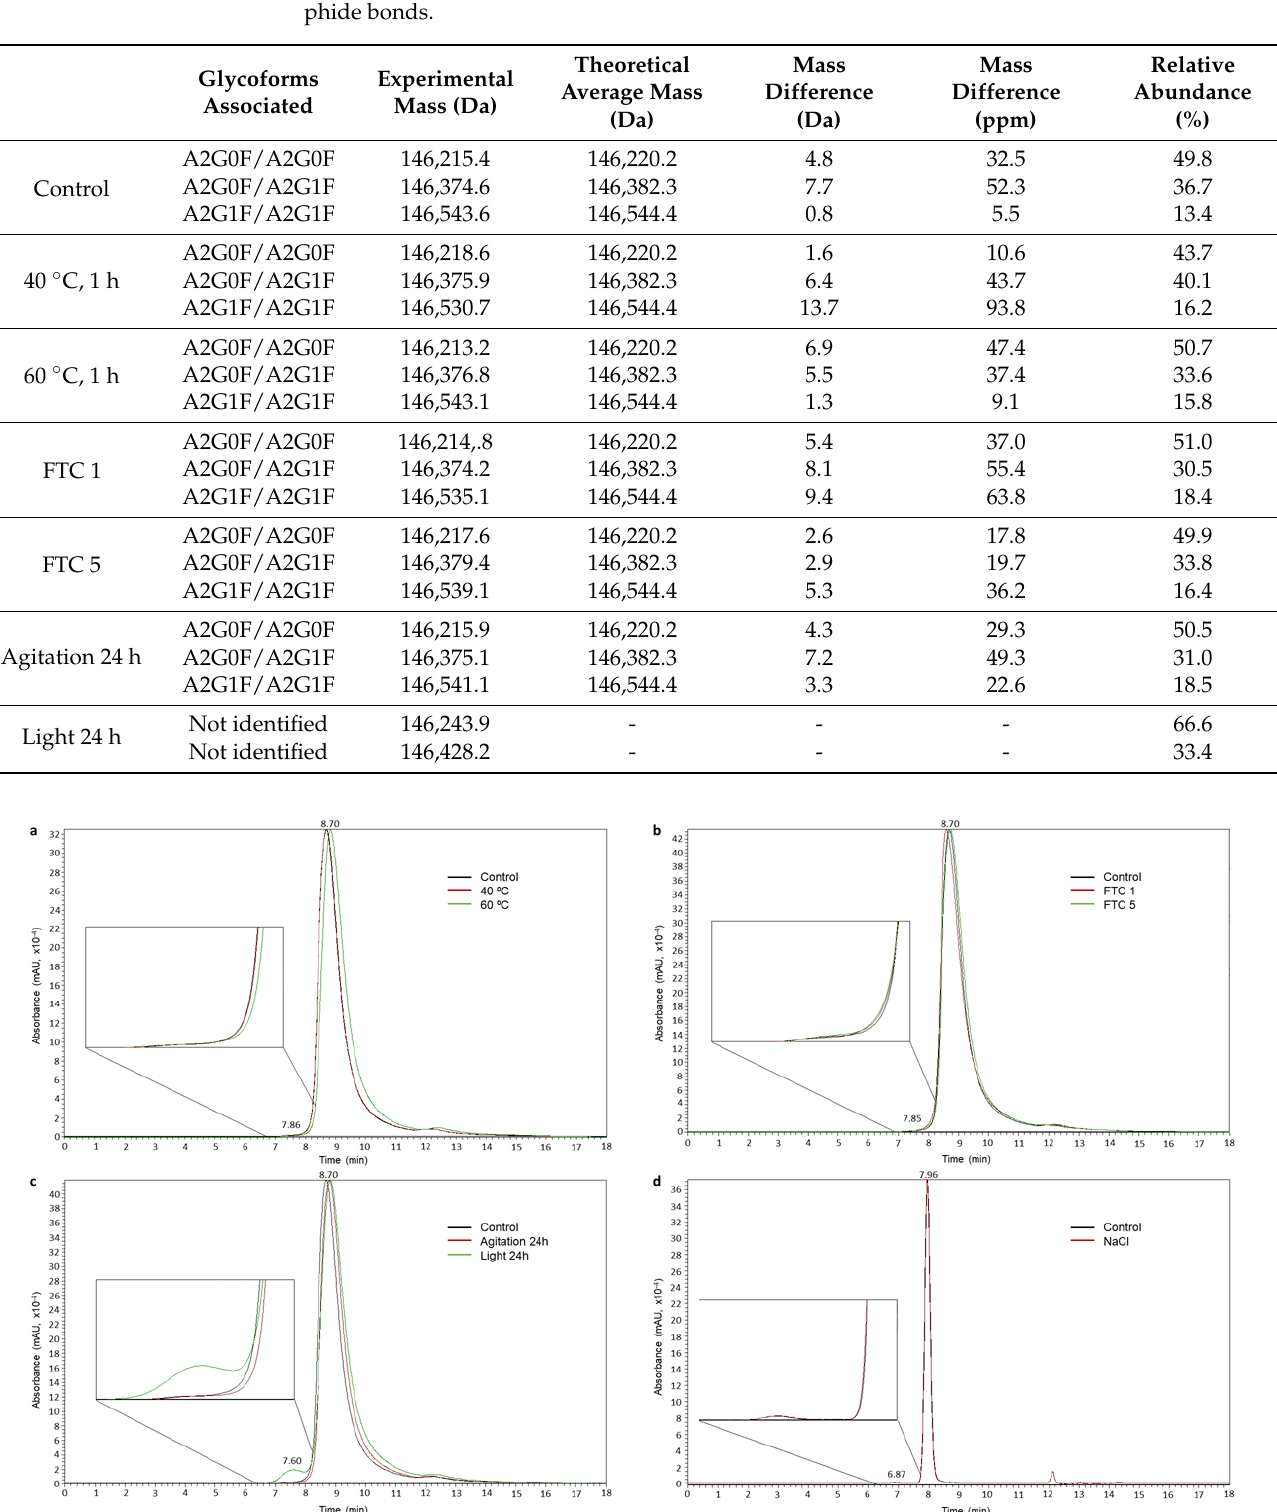
Figure 5. SE/UHPLC(UV) chromatograms for 10 mg/mL samples of nivolumab: ( a ) temperature stress; ( b ) FTC stress; ( c ) agitation and light stresses; and ( d ) ionic strength stress.